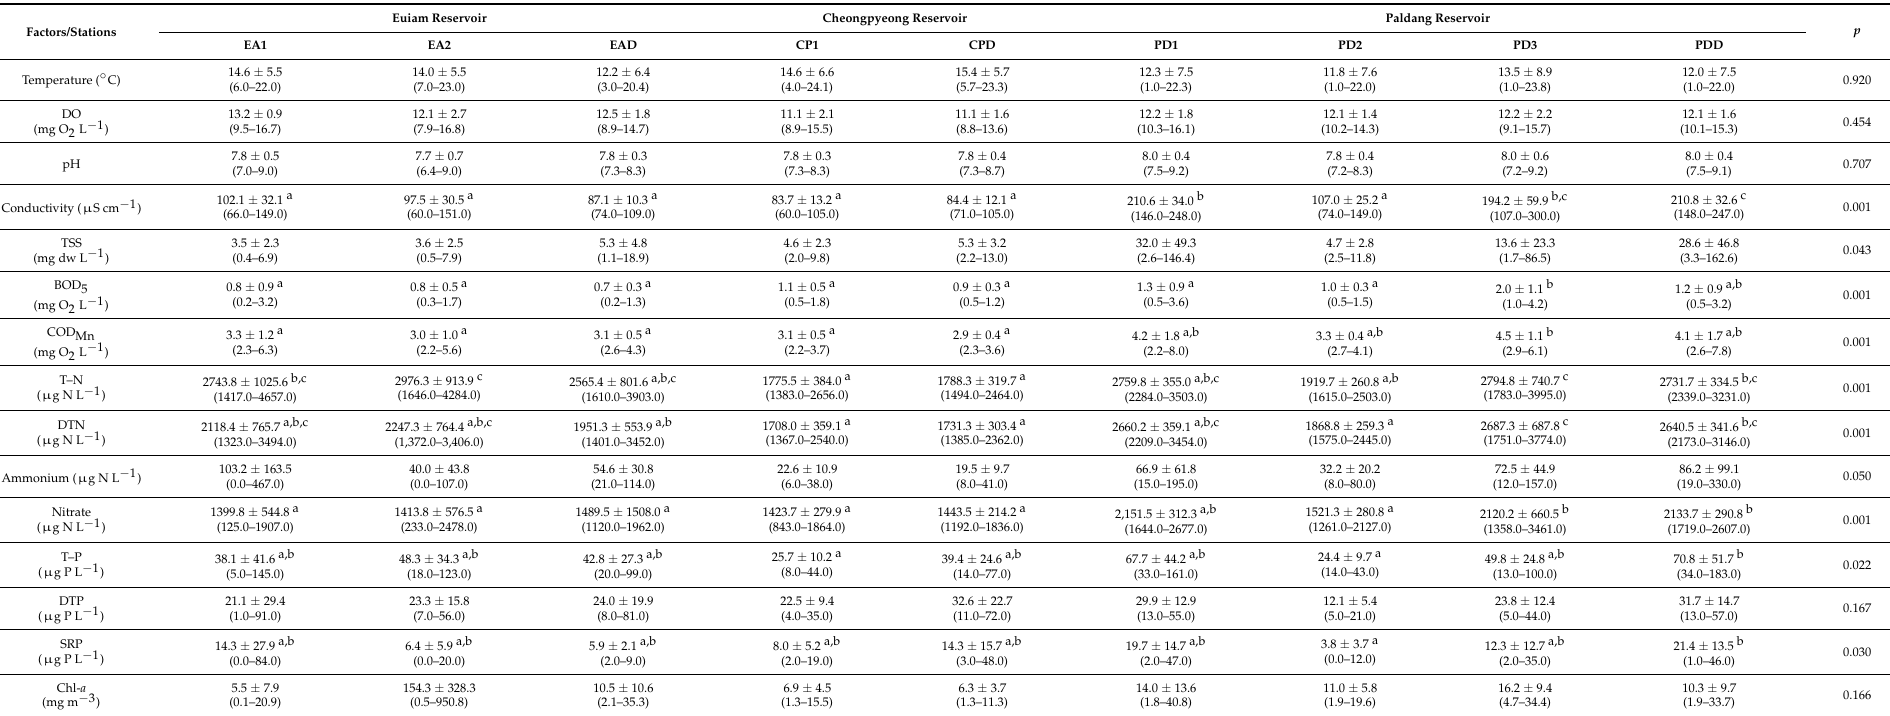
Table 2. Descriptive statistics of the monthly water quality factors determined for the major stations of the three reservoirs located on the North Han River and Han River basins from January to December 2011. The values indicate means, standard deviations, and ranges (minimum and maximum). The results of Tukey’s test are represented by a – c , where stations with different letters are statistically different from each other ( a > b > c ) and stations with the same letters are statistically similar. Data were obtained from the Korea Water Environmental Information System (http://water.nier.go.kr (accessed on 1 April 2012)) and from two stations (EA2 and EAD) additionally surveyed on 13 August and 19 September 2011. Refer to Figure 1 for the locations of the different